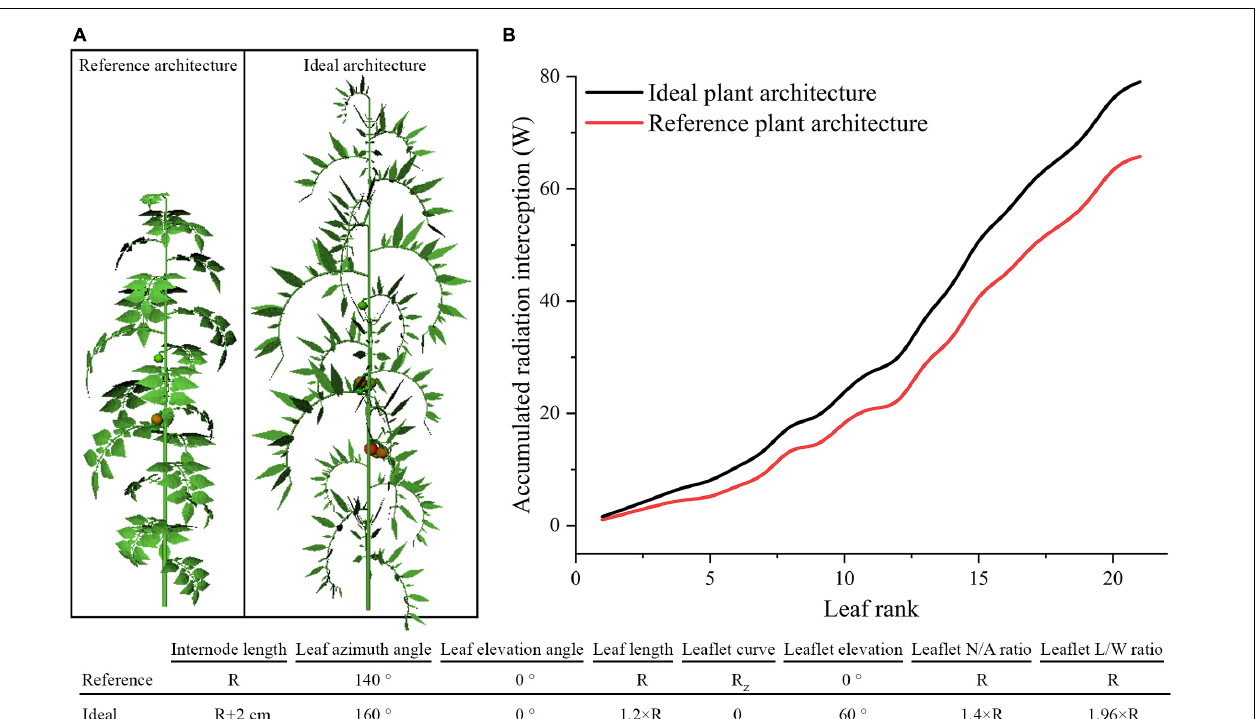
FIGURE 13 | The ideal tomato plant architecture which combined all leaf- and leaflet level optimal traits (A) . Comparison of ideal and reference plant architecture on canopy accumulated radiation interception as leaf rank increases (B)